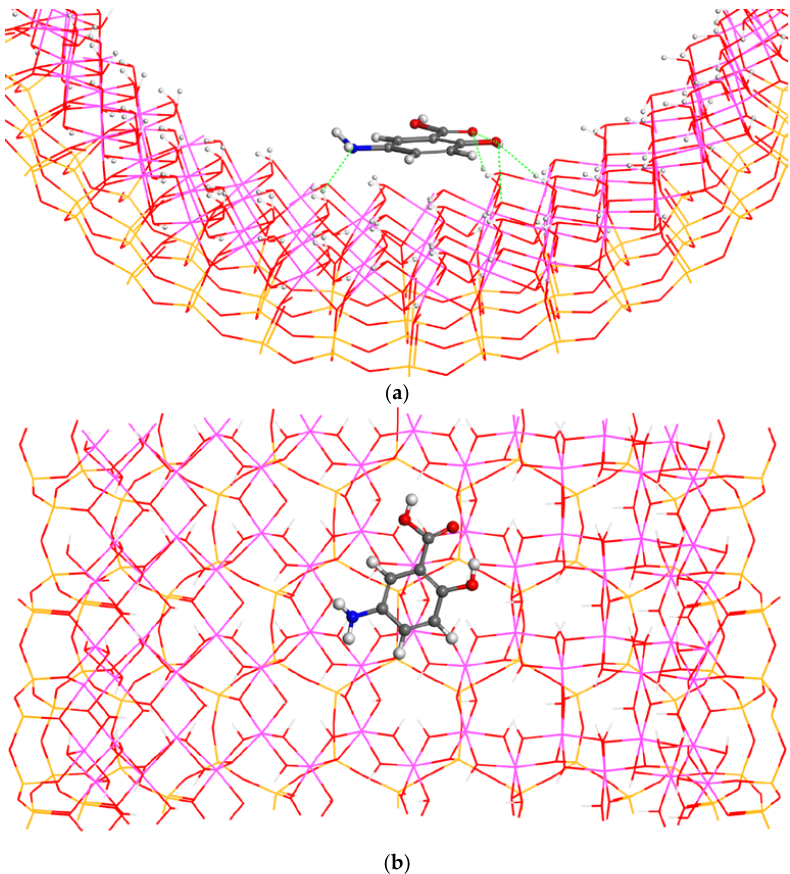
Figure 6. Optimized adsorption complex of the conformer F2 of 5-ASA placed parallel to surface with a perpendicular orientation crossed with respect to the c axis of the halloysite nanotube. Views from the (001) ( a ) and (010) ( b ) crystallographic